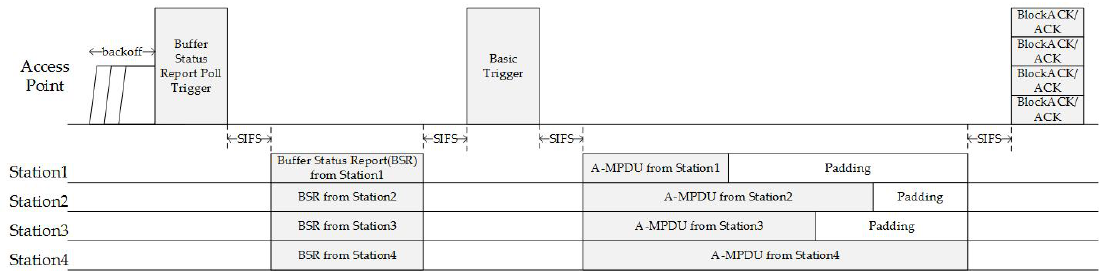
Figure 2. The frame exchange procedure of the uplink (UL) MU transmission in IEEE802.11ax